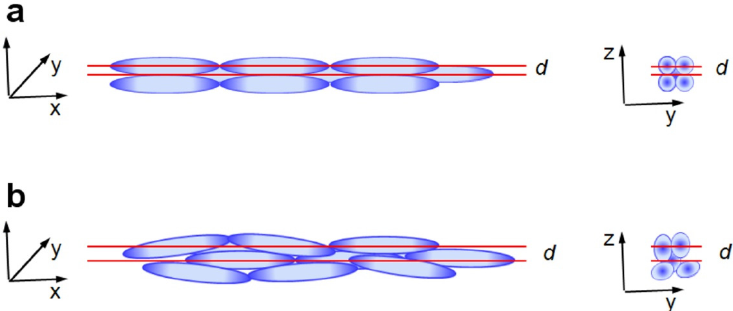
Figure 9. Schematic illustration of top layer of assembly of microspheroids with geometrical pa- rameters of P(S/PGL) s 3 ( AR = 6.41, L s = 221 nm): ( a )—body centered tetragonal colloidal crystal, for which interplanar distance d = 0.5 L s ; ( b )—quasi-nematic colloidal assembly of microspheroids with d = 0.756 L s .